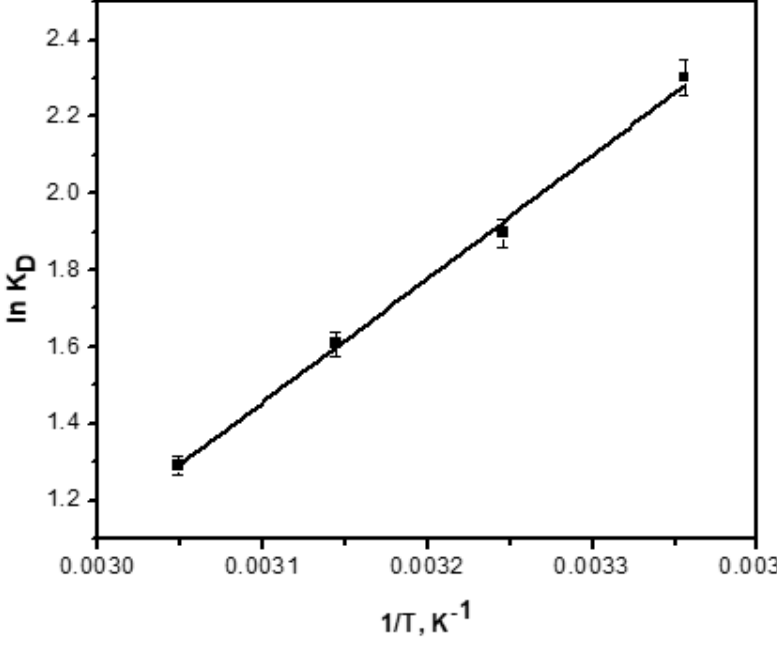
Figure 10. Relationship between ln K D and 1/T.